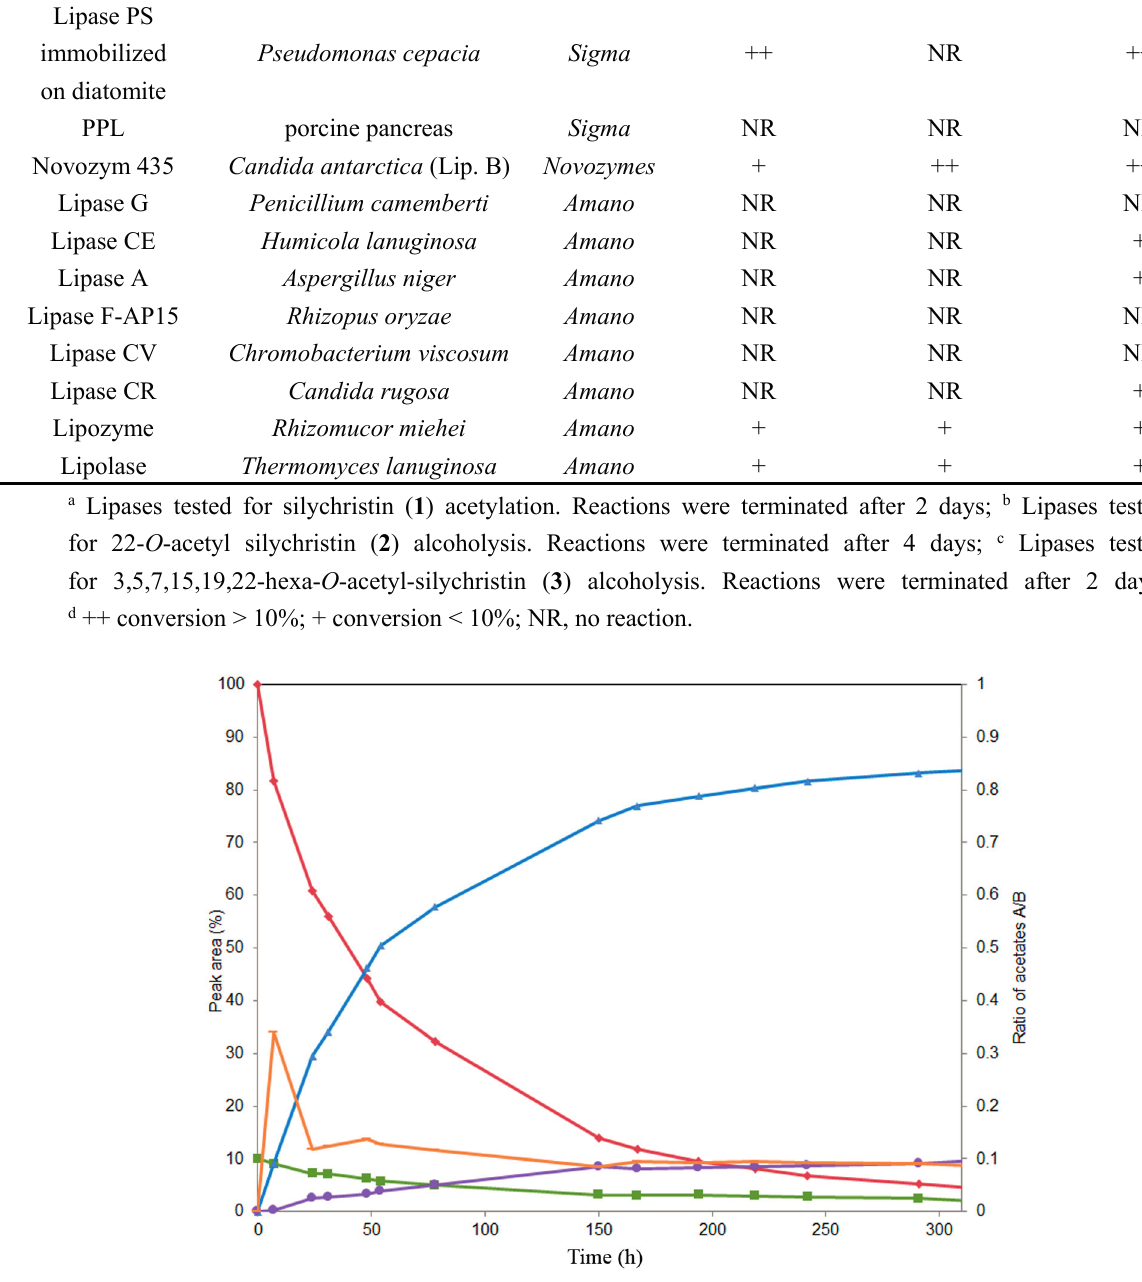
Figure 2. Time course study of lipase PS-catalyzed acetylation of natural silychristin composed of silychristin A (  ) and silychristin B (  ) yielding 22- O -acetyl derivatives, A ( ▲ ) and B (  ); (+) ratio of peak areas of 22- O -acetyl silychristin A:22- O -acetyl silychristin B (secondary axis y ; please note that this axis has a different